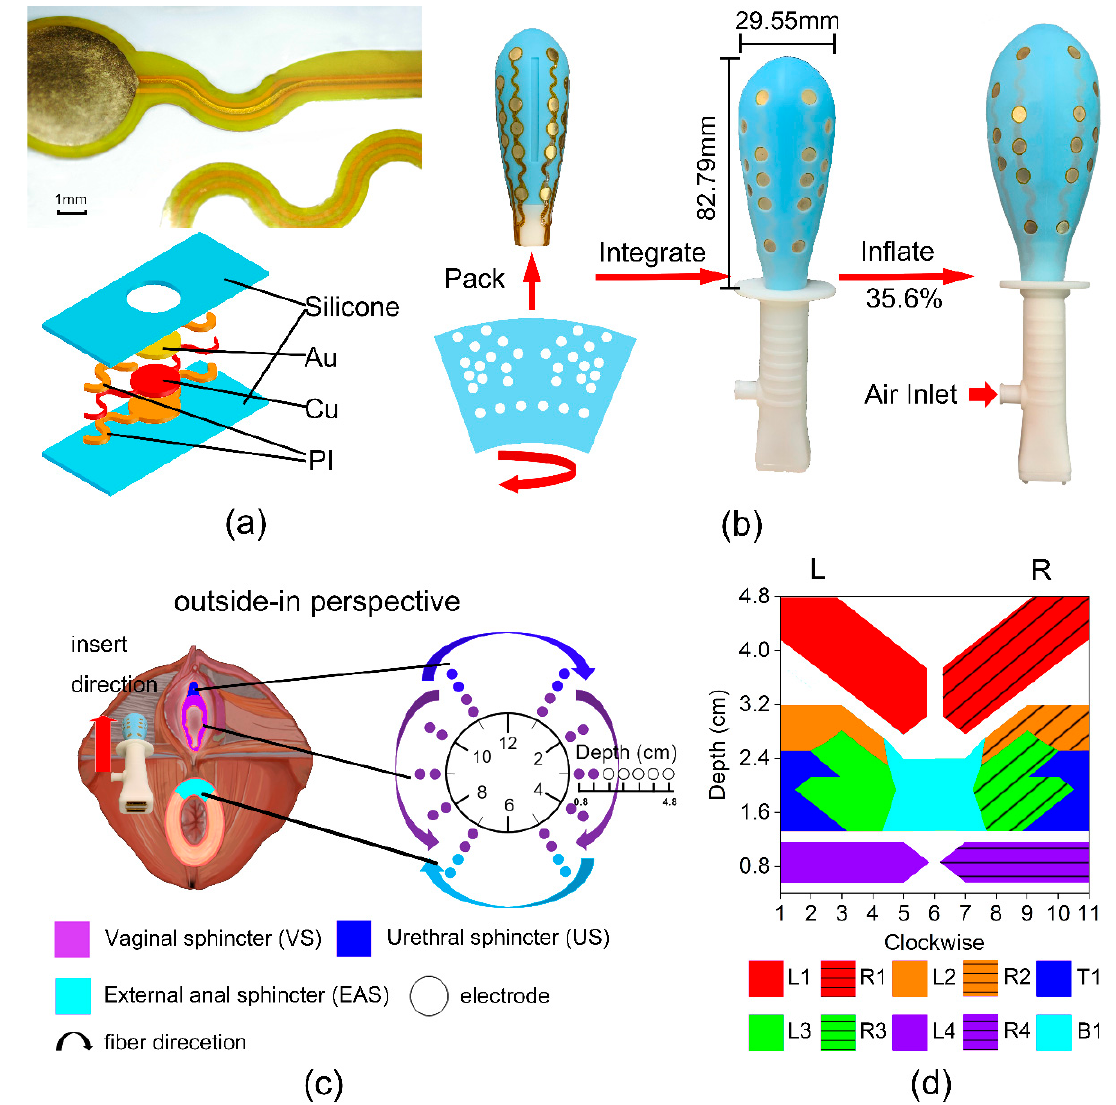
Figure 1. The ASEA and 10 PFM regions and distribution. ( a ) The localized flexible circuit image under a microscope (upper) and explosive structure (bottom) of ASEA. ( b ) The macro internal structure of ASEA (left), the ASEA before inflation (middle) and after inflation (right). ( c ) The concept map of ASEA collecting sEMG signal. The left figure is part of the PFM distribution from the outside-in perspective. ASEA is inserted from the outside of the screen to the inside. The right figure shows the clockwise, and the corresponding electrode layout direction. ( d ) The distribution map of 10 PFM regions based on physiology and PFM anatomy. Different regions are distinguished by different